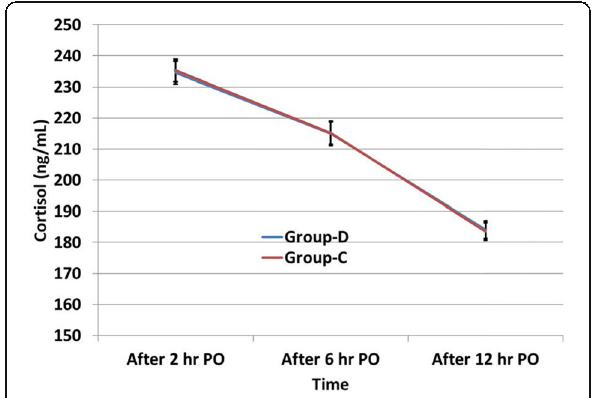
Fig. 5 Comparison between the C group and D group according to postoperative blood cortisol (90 – 220